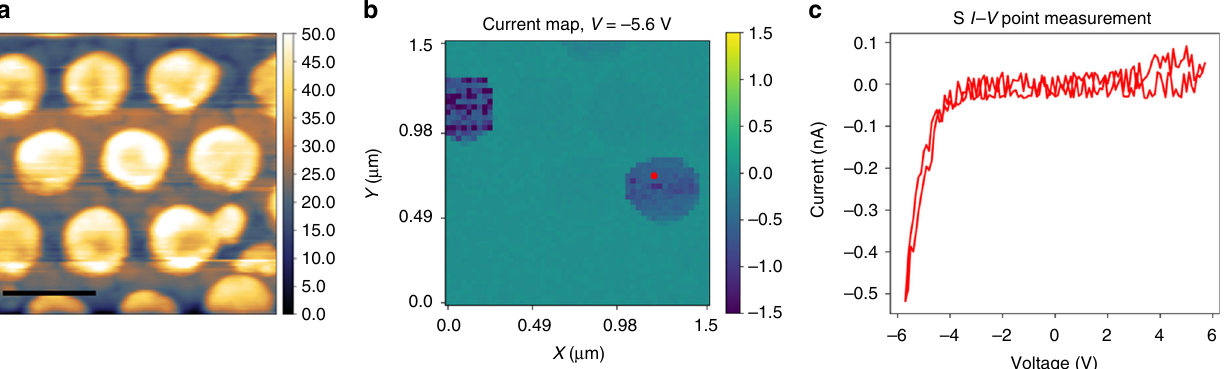
Fig. 2 S-IV spectroscopy on PZT nanocapacitors. a Topography of the region where a spectroscopic I – V experiment was performed. Scale bar, 500 nm. The results of the spectroscopy study are shown in b , where the current map at V = − 5.6 V is shown. An example of a single point I – V from the region marked by the red circle in b is shown in c